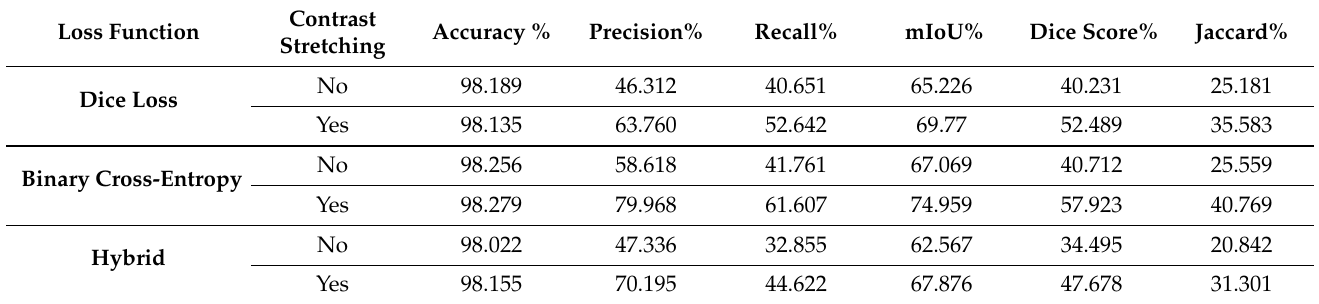
Table 2. Deep ResU-Net performance metrics.